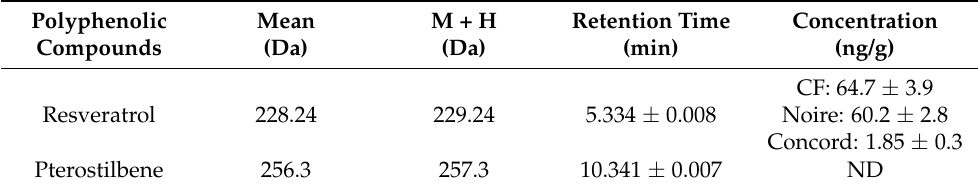
Table 2. Polyphenols present within 3 grape varieties.